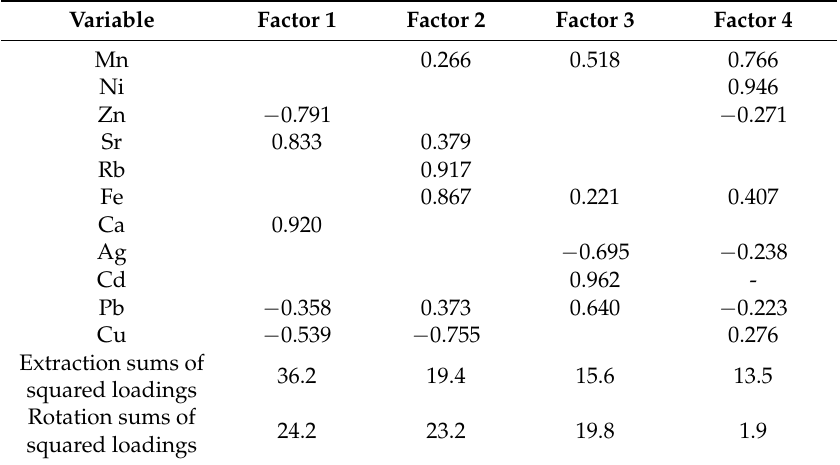
Table 5. The results of the flame atomic FA analysis of the correlation